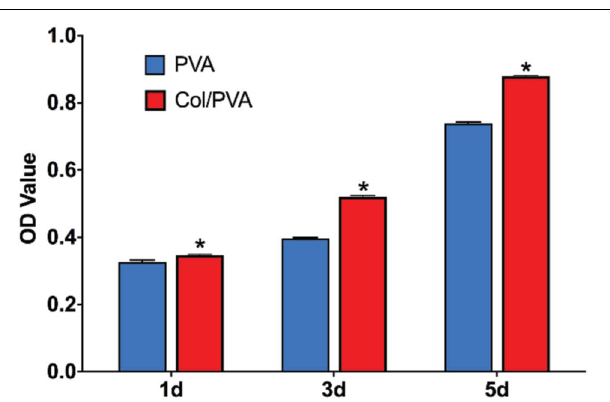
and chemical properties of collagen and PVA material in each layer, showing superior hydrophilicity as a desirable feature of GTR membranes.